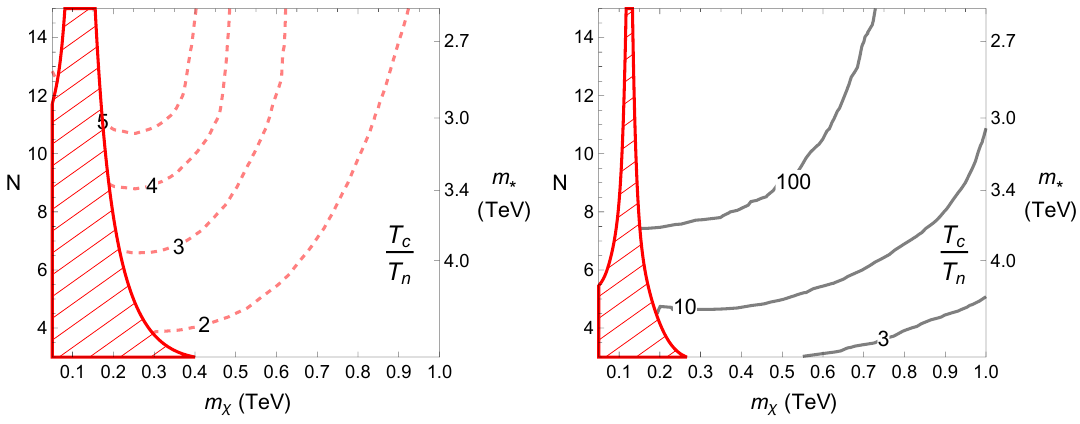
Figure 11 . The ratio T c =T n of the critical to the nucleation temperature which measures the amount of supercooling of the phase transition for a meson-like dilaton (left panel; red dashed) and a glueball-like dilaton (right panel; black solid). In the red dashed region, there is no phenomeno- logically viable electroweak